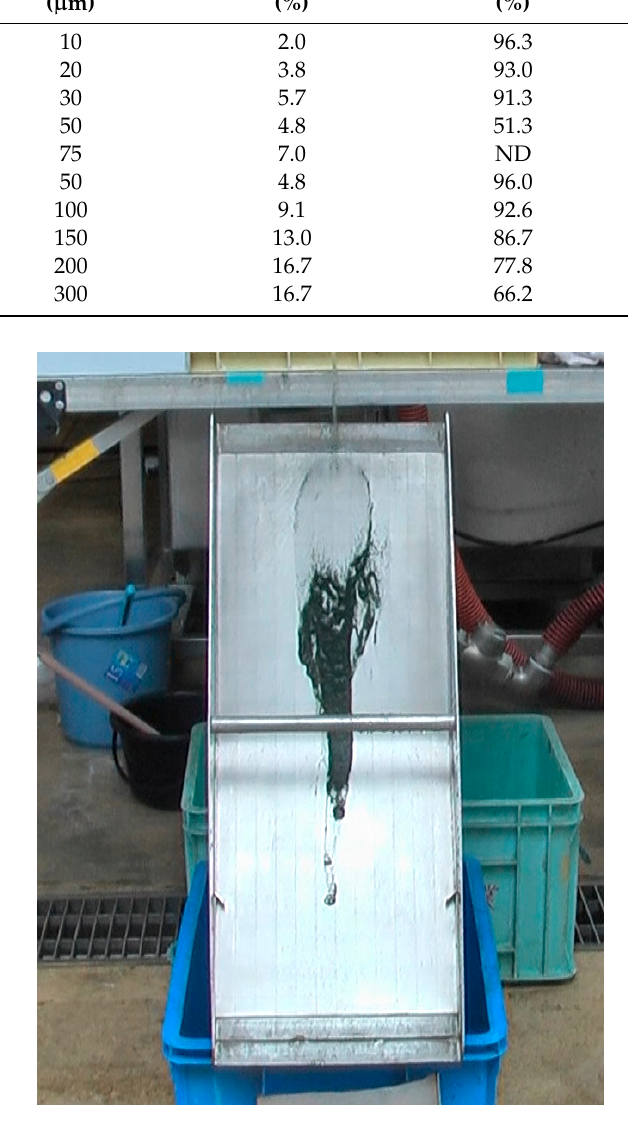
Figure 4. Harvesting of B. braunii cultured in the brackish medium (BM) using an inclined solid–liquid separator with a wedge-wire screen (150 µm slit size).